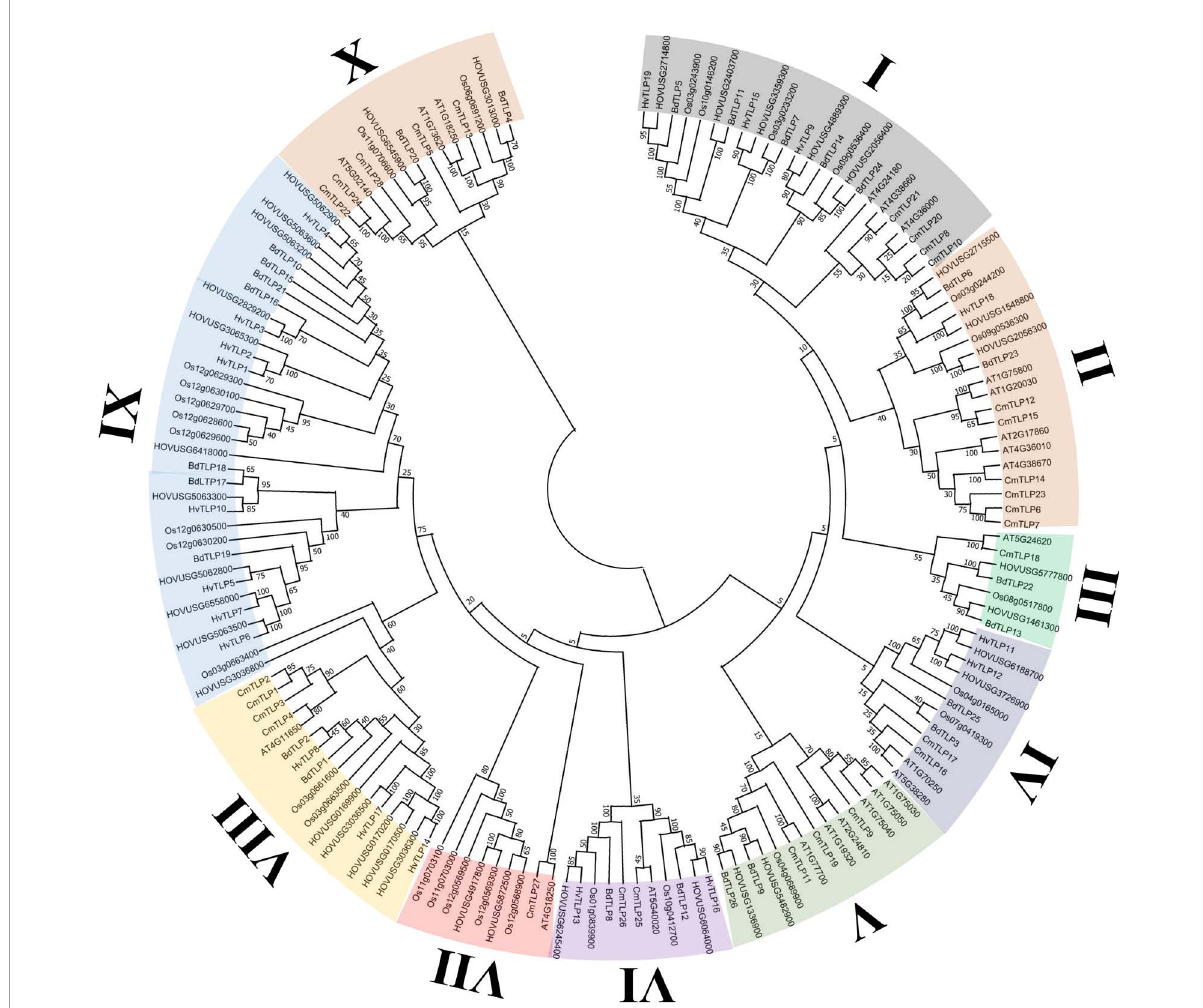
FIGURE1 Phylogenetic relationships of TLPs from Qingke, Hordeum vulgare , Cucumis melo , Oryza sativa , Brachypodium distachyon , and Arabidopsis thaliana . The phylogeny was constructed by MEGA 11, using the maximum likelihood (ML) method with 1000 bootstrap replicates. The inferred phylogeny was visualized in the Evolview online server. TLPs were classified into 10 groups, these indicated by different background colors.